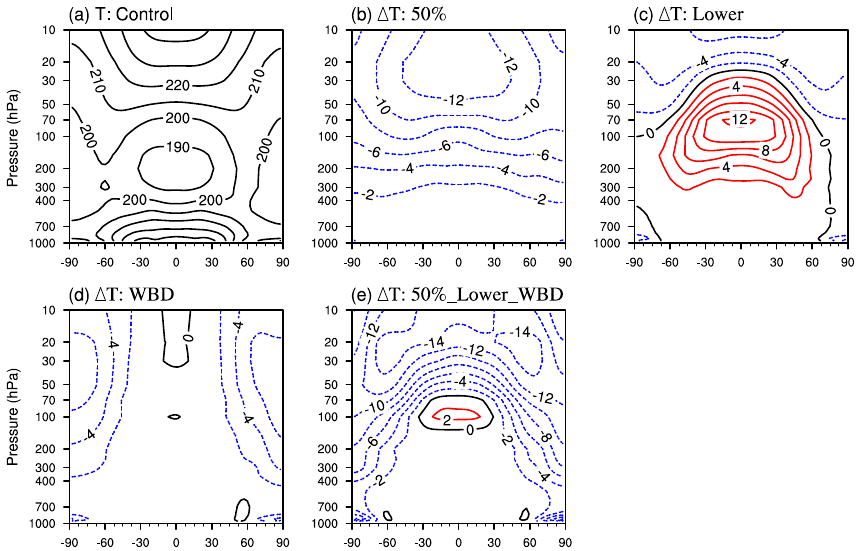
Fig. 3. Vertical cross-sections of annual- and zonal-mean air temperatures with the present-day ozone (a) and temperature differences between various ozone scenarios and the control experiment. (b) 50%, (c) lower, (d) WBD, and (e) 50% Lower WBD. The CO 2 level is 100ppmv. Contour intervals are 10K in (a) and 2K in (b–e) .